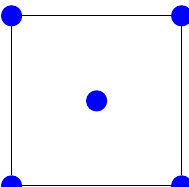
Figure 1. C 4 plus an isolated vertex.